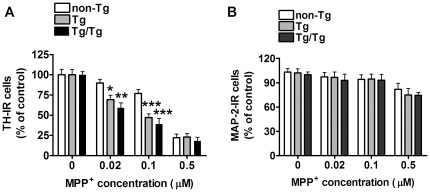
MPP+ effect on non-Tg, Tg and Tg/Tg mixed neuron-astrocyte cultures.
A) MPP+ effect on TH-IR cell number in non-Tg (n = 18), Tg (n = 34) and Tg/Tg (n = 22) neuronal cultures. B) MPP+ effect on MAP-2-IR cell number in non-Tg (n = 18), Tg (n = 34) and Tg/Tg (n = 22). Two-way ANOVA followed by Bonferroni multiple comparison test: *P<0.05, **P<0.01, ***P<0.001 vs respective non-Tg value.